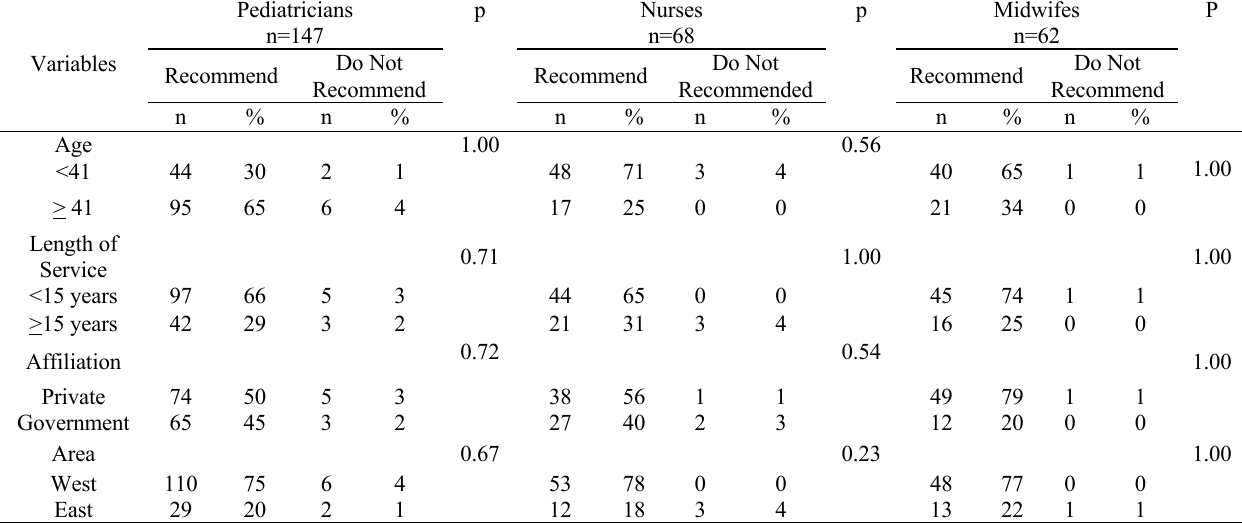
Table 4. Multivariate analysis of HCP’s recommendation level toward soy formula for non-cow’s milk drinker based on demographic